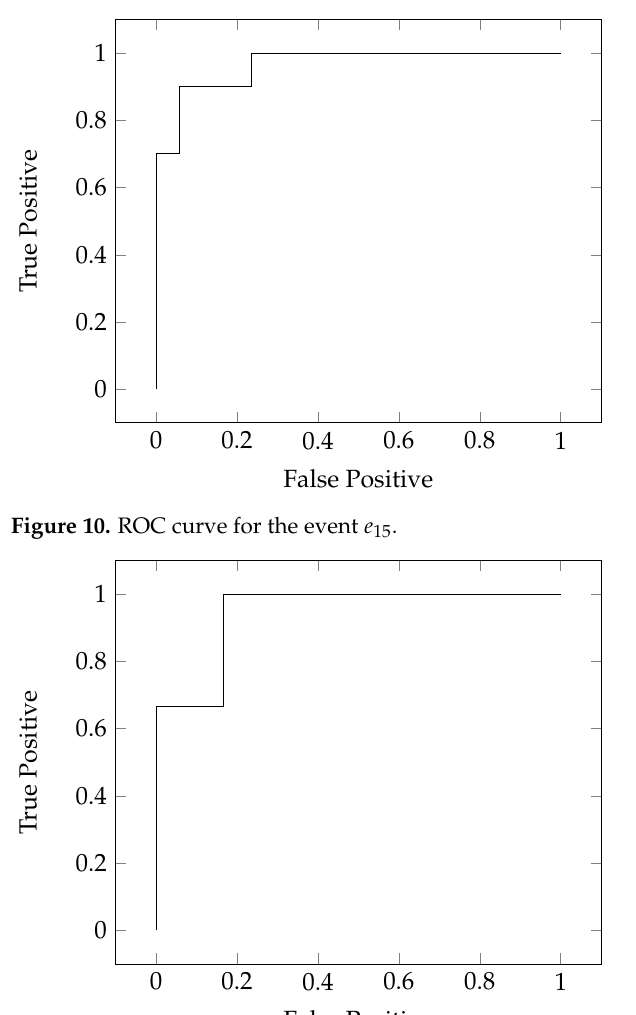
Figure 9. ROC curve for the event e 5 .